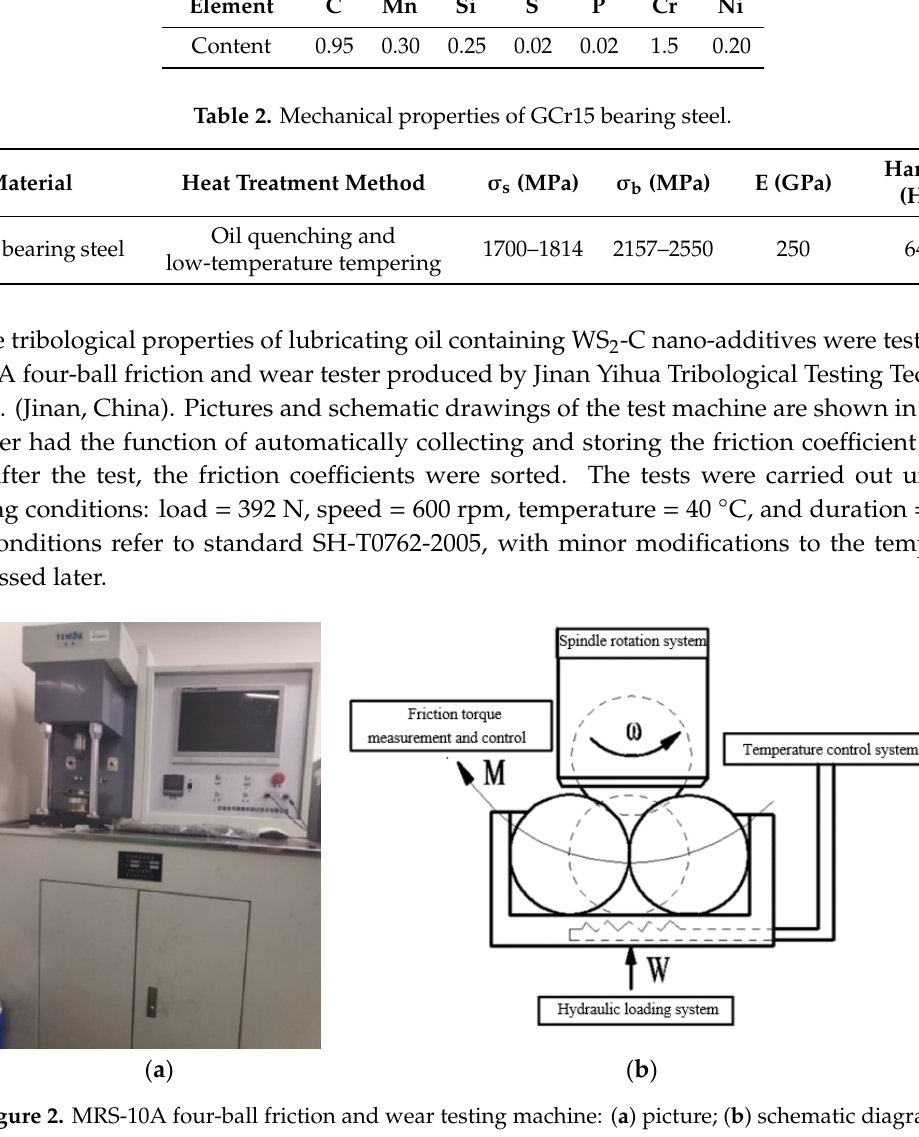
Table 3. Lubricating oils with different types of additives.